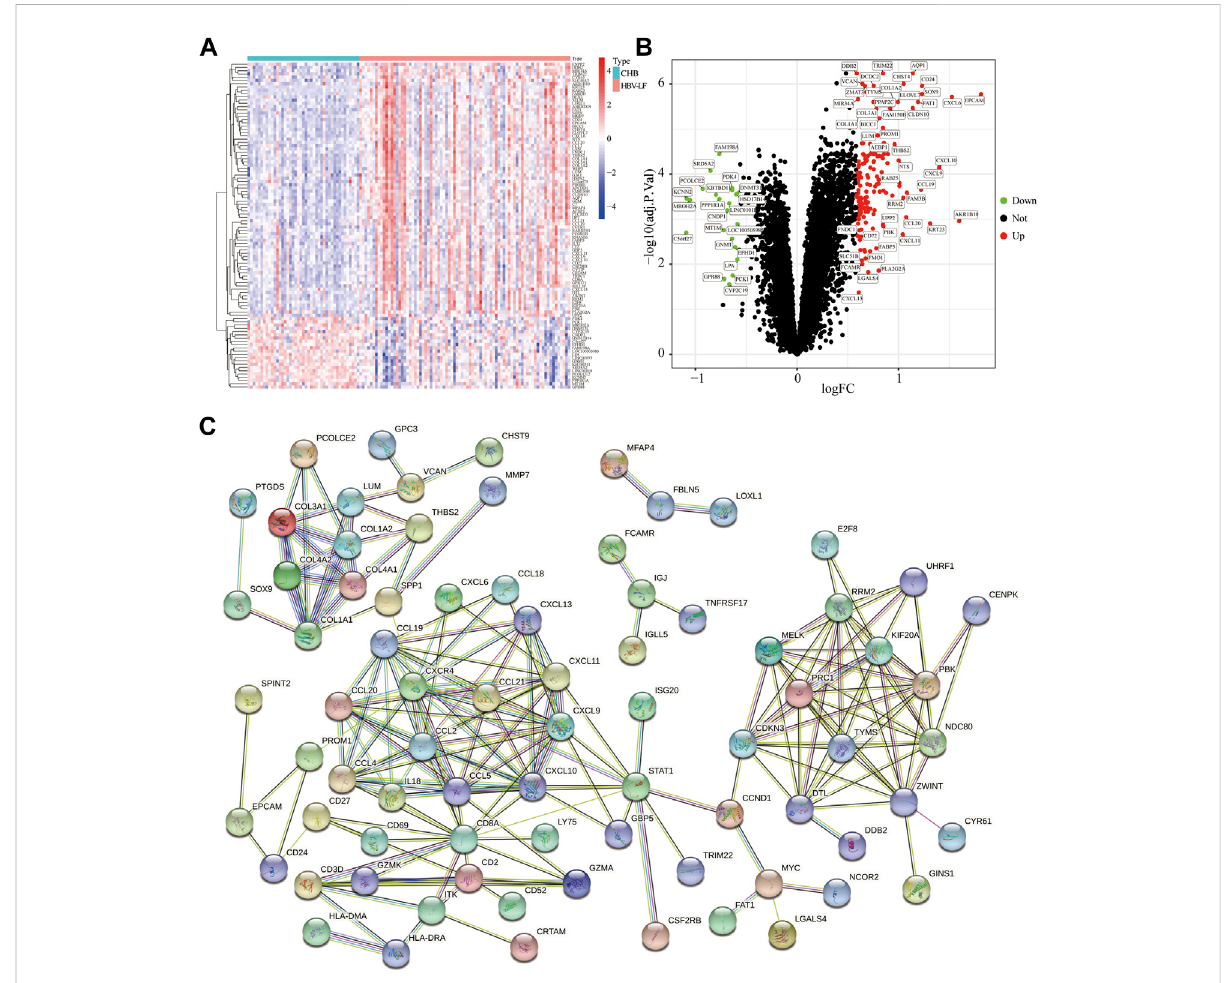
FIGURE 2 Identi fi cationofDEGsbetweentheHBV-LFandCHBsamples. (A) TheheatmapoftheDEGs. (B) Thevolcano mapofDEGs. (C) ThePPInetwork of